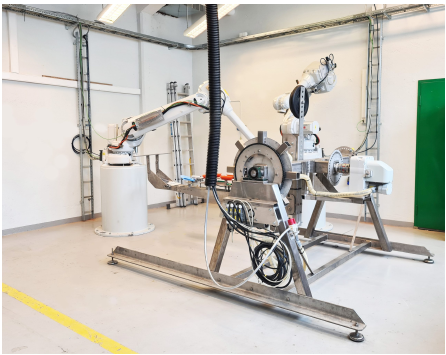
Figure 2. Carcass handling unit in the RoButcher laboratory.